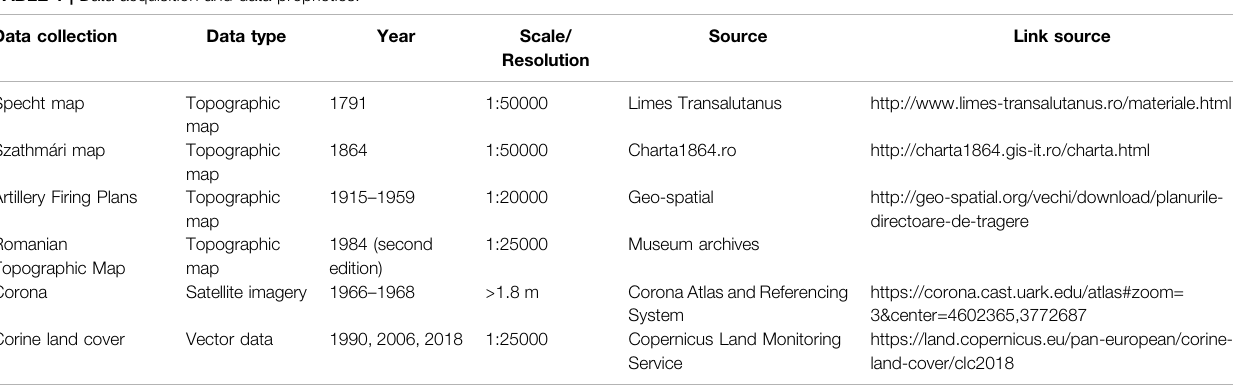
TABLE 1 | Data acquisition and data